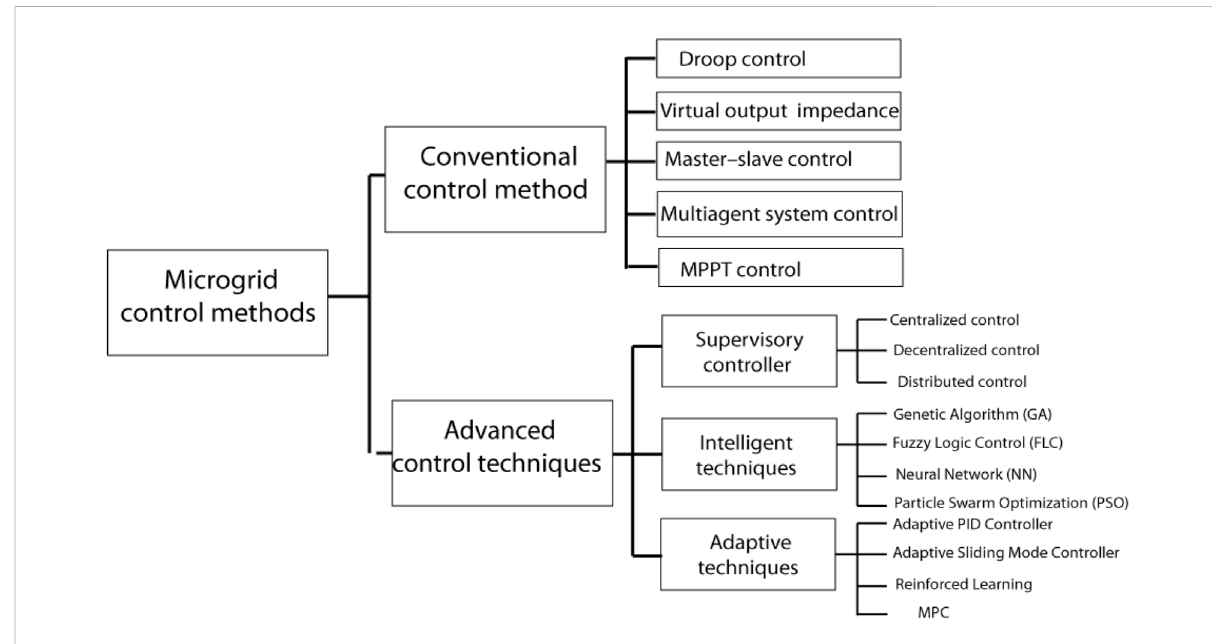
FIGURE 2 Classi fi cation of microgrid control